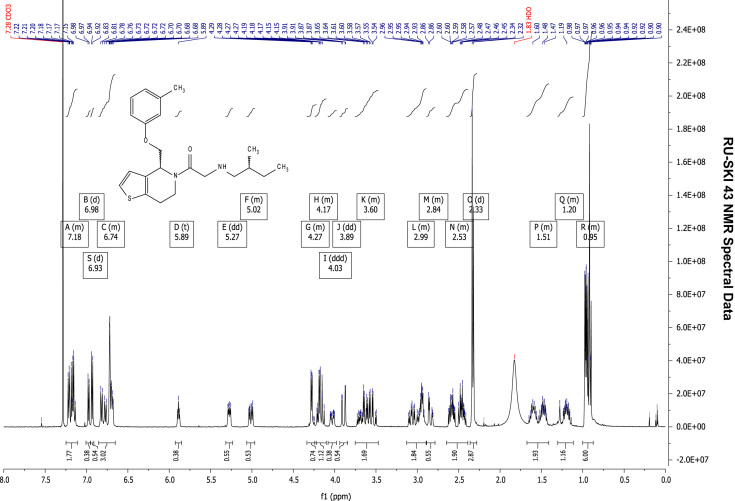
1H NMR (400 MHz, CDCl3) of RU-SKI 43
(9b).